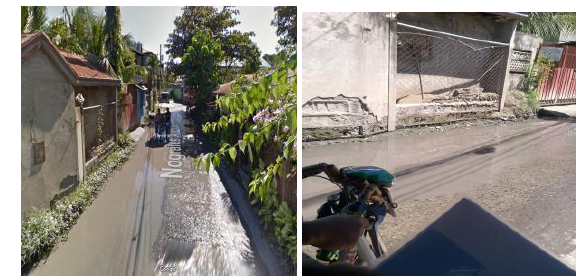
Figure 14. Left - Google Street View image of a street in Davao City. Right - Photograph of the same location during the validation fieldwork.